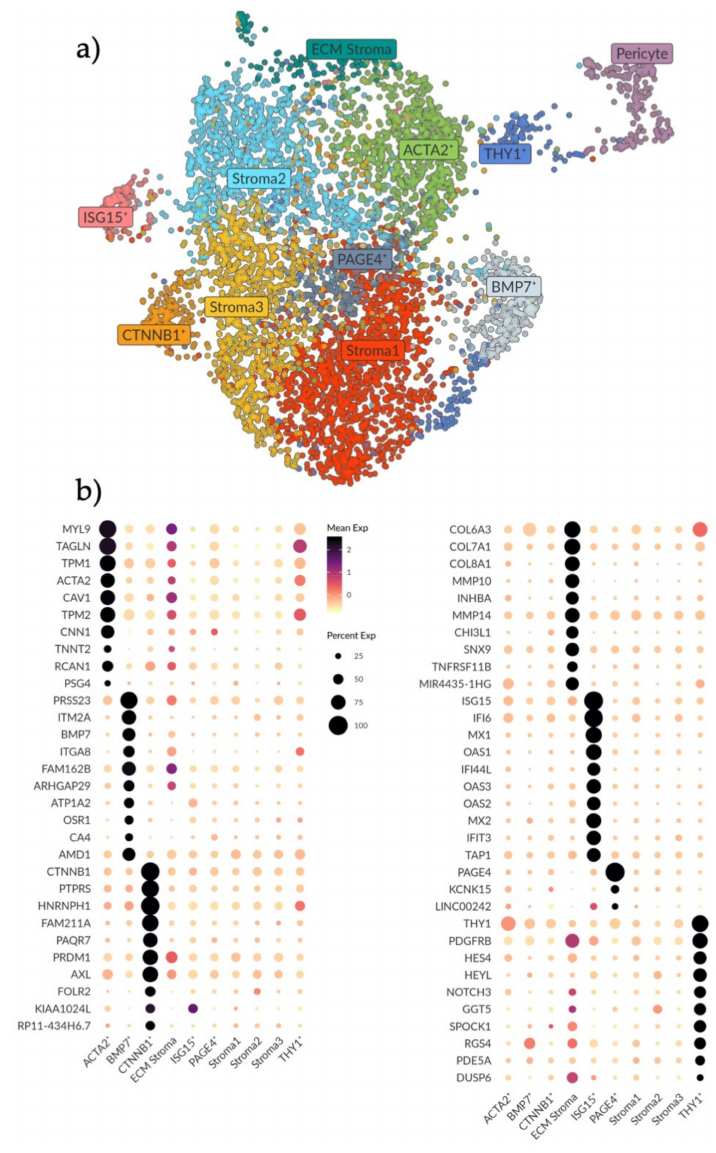
Figure 2. Analysis and subtyping of the endometrial stromal cell compartment. ( a ) UMAP plot showing ten clusters of endometrial stromal cells and a cluster of pericytes on the far right. Clusters are labelled as per their identified expression profile in b. ( b ) Dotplot showing the top differentially expressed genes (rows) for the ten stromal clusters (columns). Genes were selected based on the MAST test with a minimum log fold change of 2 and an adjusted p -value of 0.05. Note that the color scale is clipped at 2.5. Stroma 1, 2 and 3 do not show any unique expression. The PAGE4+ cluster shows a very biased differential expression for PAGE4 only. The ECM, ACTA2+ and BMP7+ clusters show a higher expression for genes involved in the ECM breakdown, remodeling and organization. The CTNNB1+ cluster shows higher expression of genes involved in epithelial regulation and innate immunity. The ISG15+ cluster shows higher expression for genes involved in innate immunity. The THY1+ cluster shows higher expression of genes involved in Notch